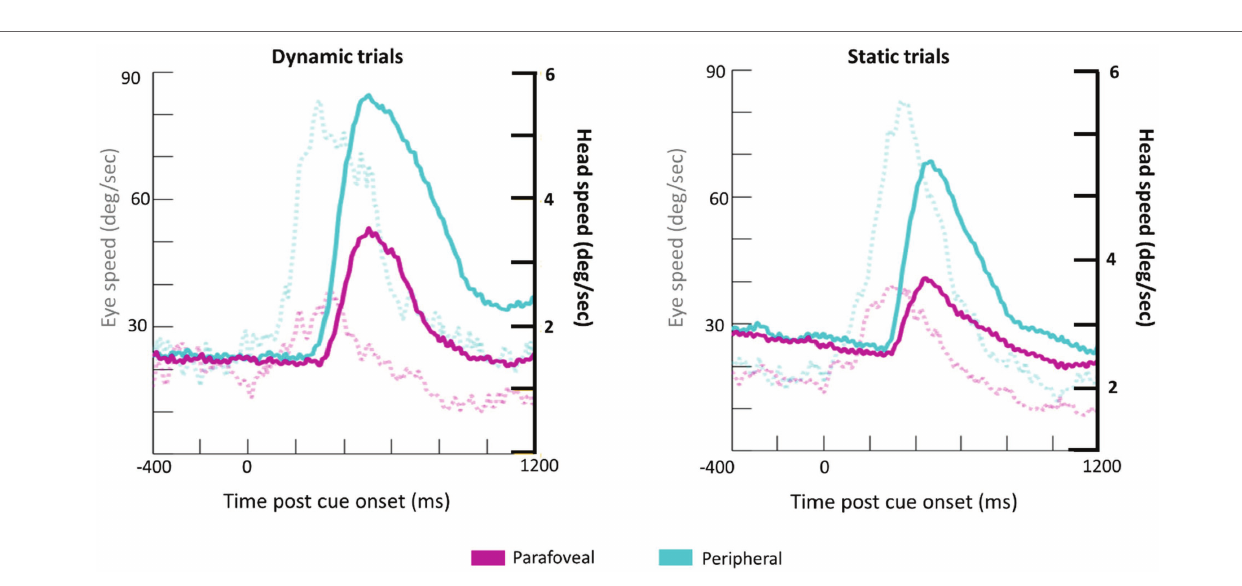
FIGURE 5 | Grand average waveforms for eye speed (transparent, dotted lines; y-axis on the left) and head rotational speed (bold lines; y-axis on the right) for Dynamic (left) and Static (right)